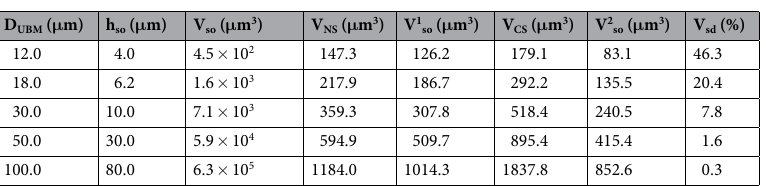
Table 3. The volume percentage of solder depleted by surface diffusion of Sn. D UBM : the diameter of UBM. h so : the height of solder. V so : the total volume of soler. V NS : the volume of Ni 3 Sn 4 on the circumference of Ni UBM. V